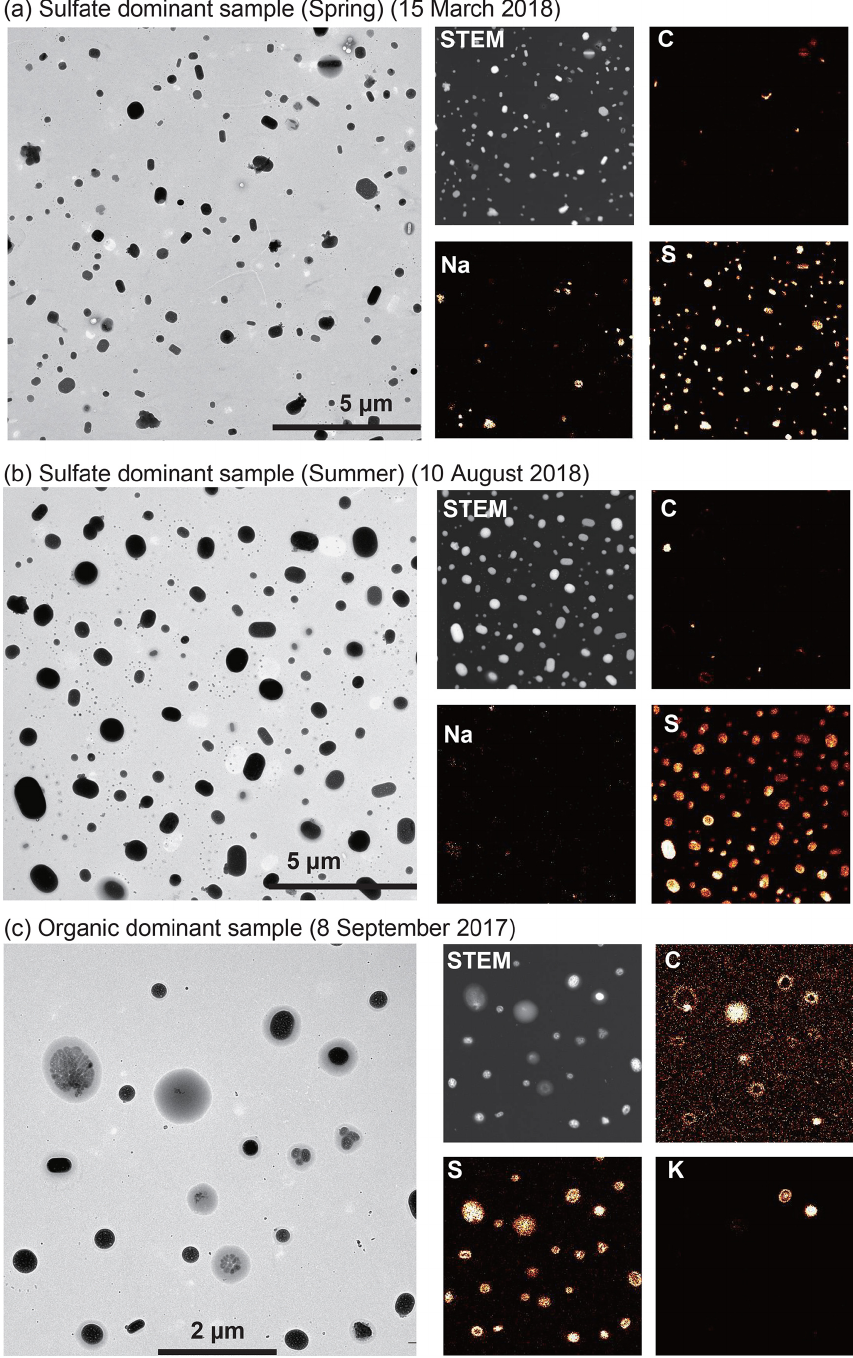
Figure 6. TEM (left) and elemental mapping images (right) of ambient aerosol particles with relatively high sulfate particle fractions in (a) spring (76%), (b) summer (95%), and (c) particles with carbonaceous coatings. The samples were collected on (a) 15 March 2018 (12:00), (b) 10 August 2018 (12:00), and (c) 8 September 2017 (12:30). (a, b) Most particles are sulfate, with some containing Na and C (soot). (c) Organic matter has relatively low contrast (grey color) and coats sulfate particles (black). The distributions of C and S in the mapping images correspond to organic matter and sulfate particles,